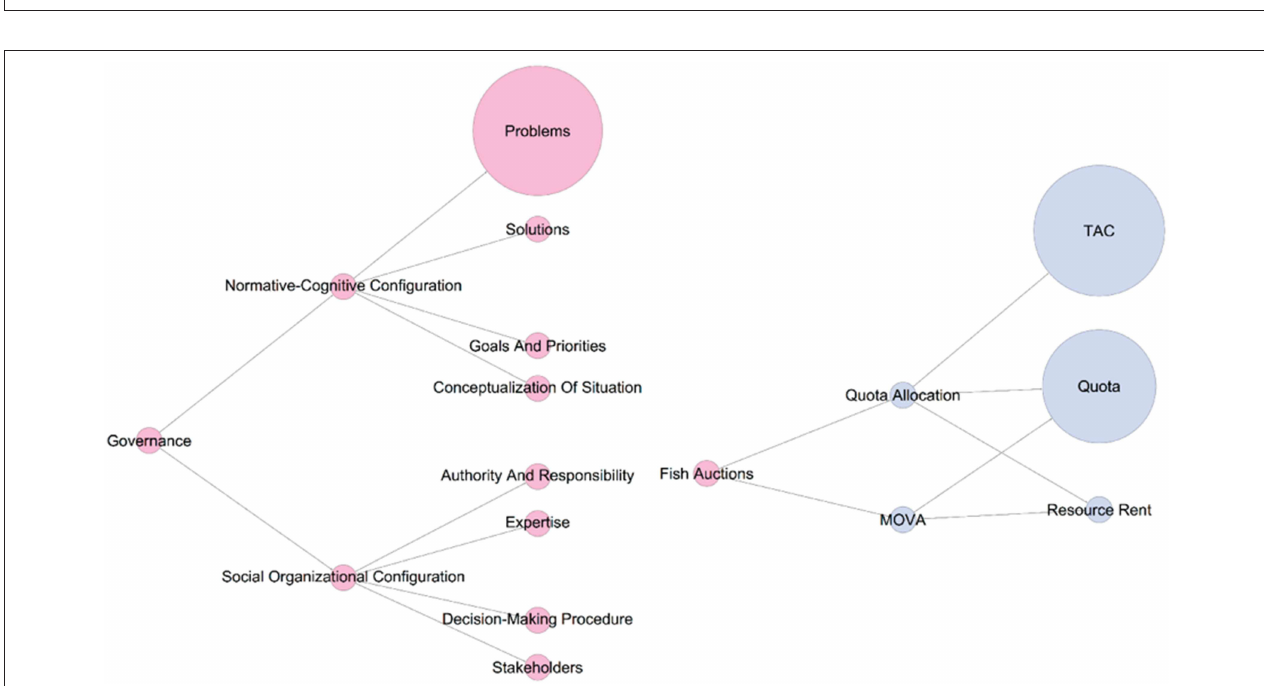
FIGURE 3 | A visual representation of the Human Dimension Aspects (HDAs) governance ( left ) and fish auctions ( right ) and the Level 2 and Level 3 variables that were used to model these HDAs. The size of each node represents the relative importance of the variable (i.e., the number of publications using it) and the color indicates its dimension (pink: human; blue: economic; green: environmental; white: other/more than one dimension). The position of each node (left—middle—right) indicates its level (Level 1—Level 2—Level 3).